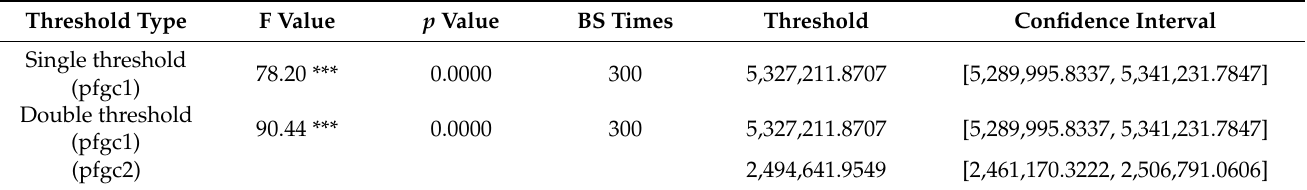
Table 3. Test results of threshold